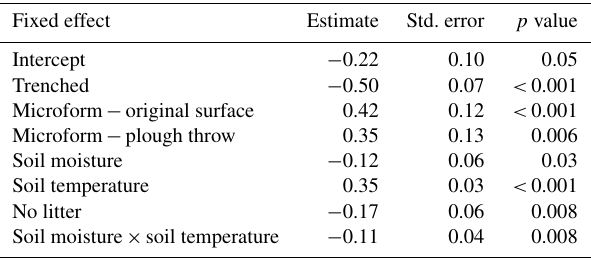
Table 1. Model estimates with standard errors and p value for the best-fit model. All numerical predictors were standardized to 1 stan- dard deviation prior to